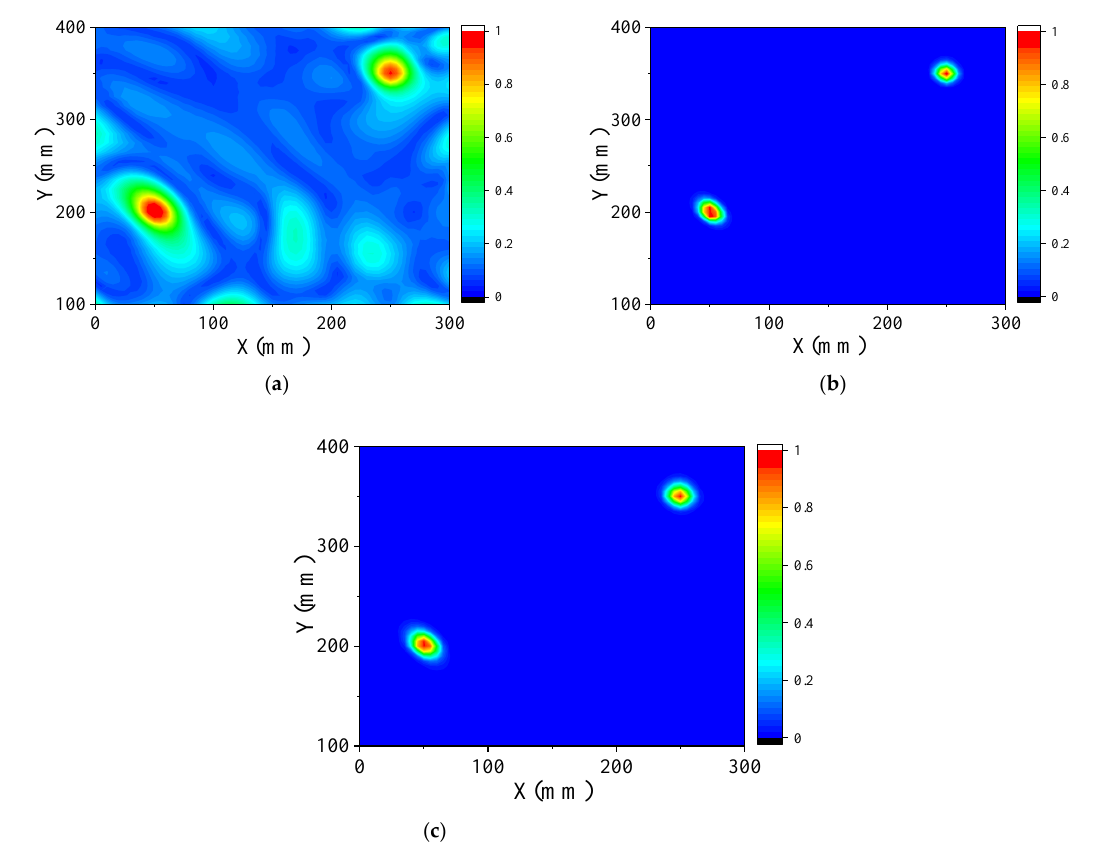
at the PIM source location for the UWB-CS method and the SI-CS method is plotted in Figure 11. By comparison, it can be found that the area of the SI-CS peak imaging section is only 25% compared to the UWB-CS method. This allows SI-CS to characterize the PIM source location more precisely.